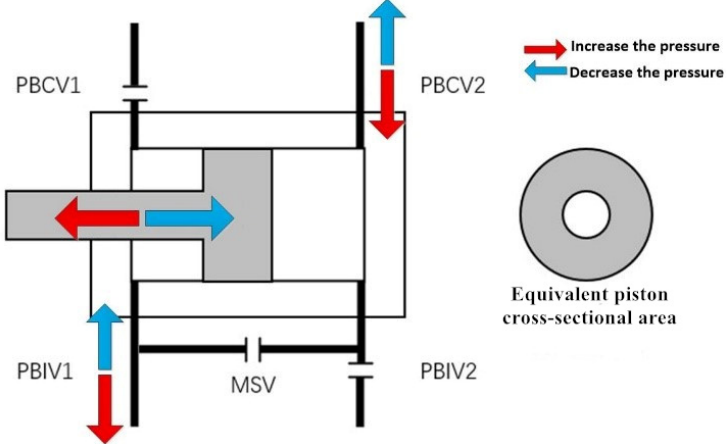
Figure 4. The flow direction of brake fluid and the action of solenoid valves under medium pressure mode.